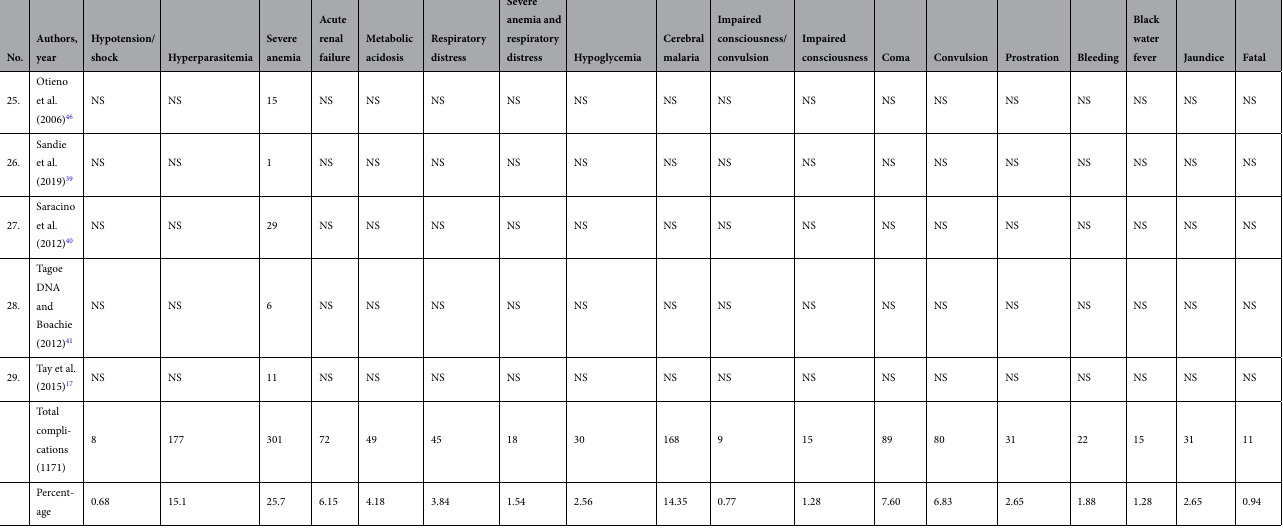
Table 3. Severe complications of co-infected patients. NS Not